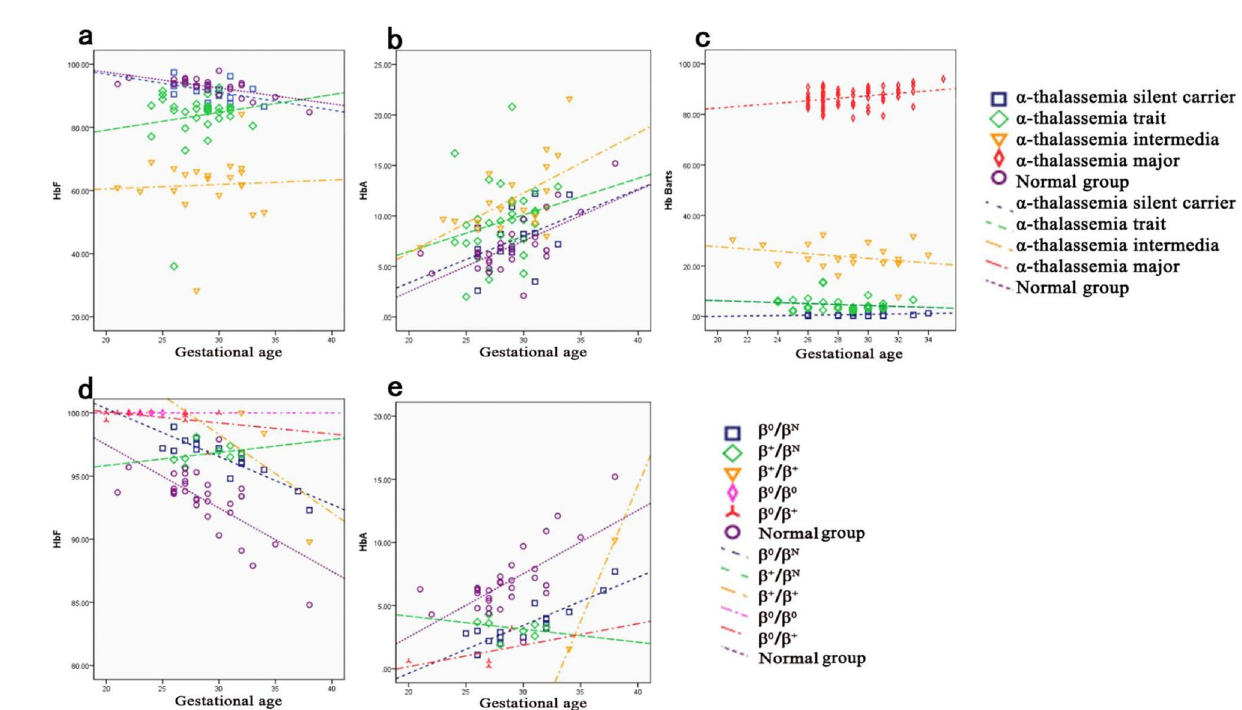
Figure 2. Distribution of hemoglobin fractions in four α-thalassemia genotypes and five β-thalassemia genotypes at different gestational ages. The trends of HbF ( a ), HbA ( b ), Hb Barts ( c ) with increased gestational ages in four α-thalassemia genotypes carriers and normal group were illustrated, as well as trends of HbF ( d ), HbA ( e ) in five β-thalassemia genotypes carriers and normal